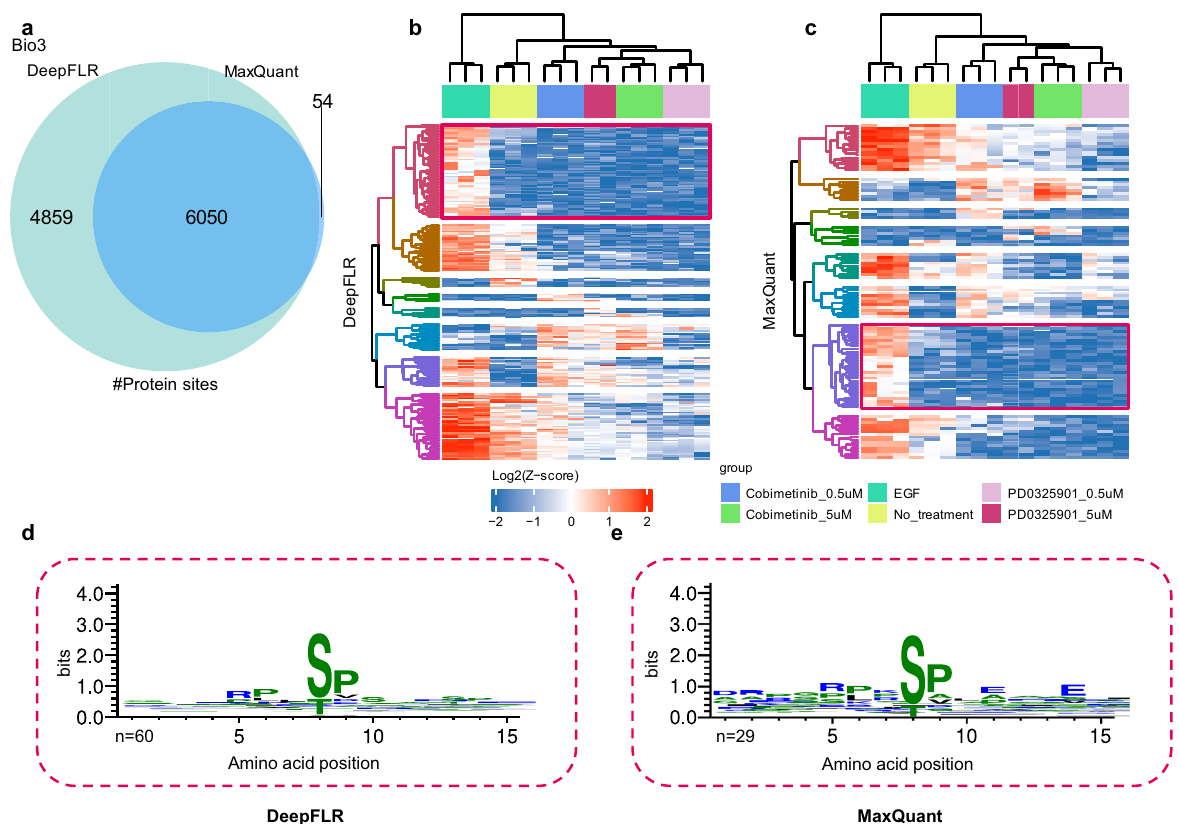
Fig. 4 | Analysis of biological sample Bio_3 by DeepFLR. a Venn diagram of the number of protein phosphosites identi fi ed by DeepFLR and MaxQuant alone. Heatmap of unsupervised clustering analysis of signi fi cantly regulated phospho- sites obtained by b DeepFLRand c MaxQuantalone.Amino acid sequencelogo for the EGF up-regulated and MEK inhibitors down-regulated phosphosites localized